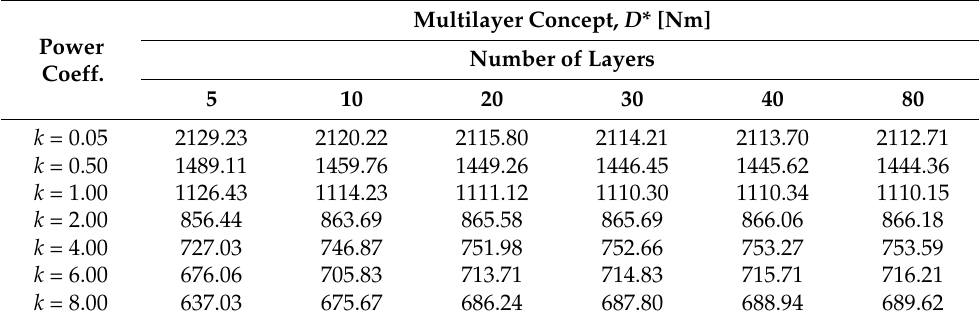
Table 5. Layer number influence on bending rigidity.